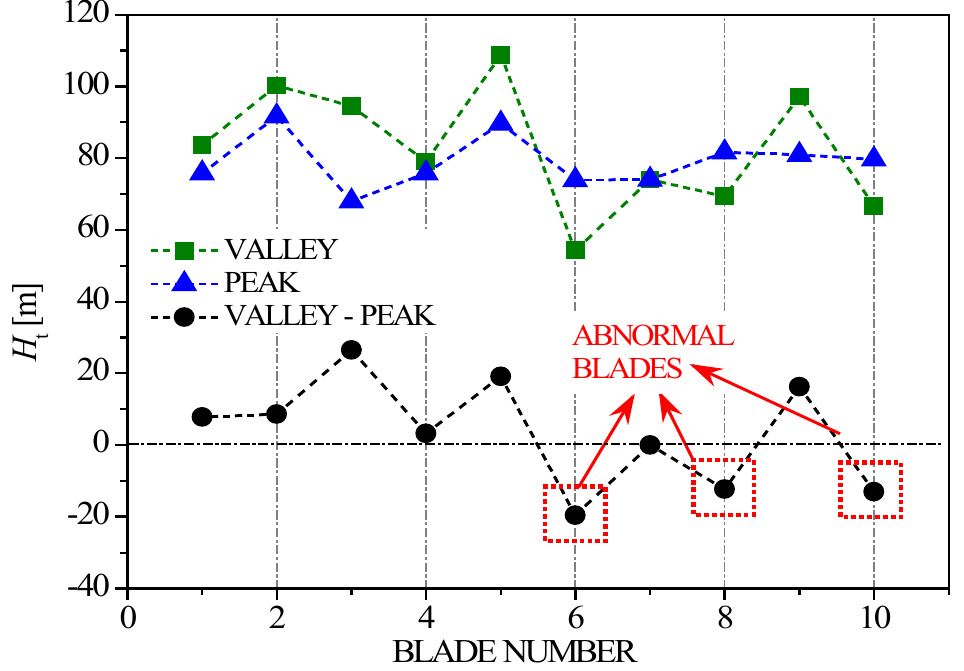
Figure 7. Distribution of impeller blade capacity for